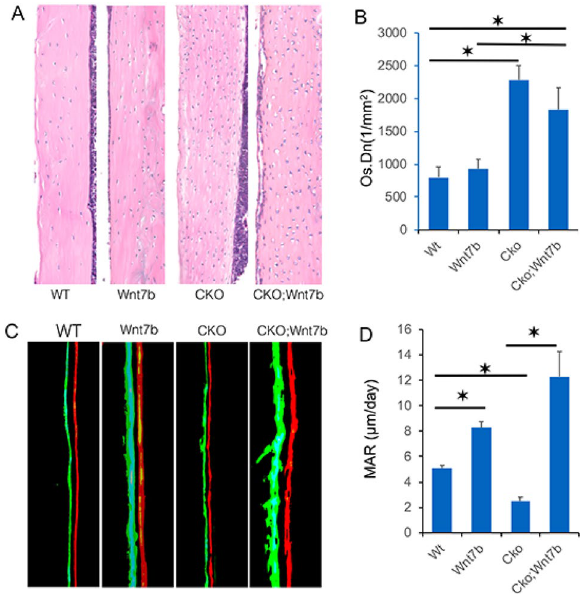
Figure 5. Overexpression of Wnt7b restores periosteal bone growth in Bmpr1a-deficient mice. ( A ) Representative H&E staining of the femoral cortical bone in littermate mice at P33. ( B ) Quantification of osteocyte density in the cortical bone. * P < 0.05, two-way ANOVA, n = 3 (females). ( C ) Representative images of calcein and alizarin double labeling at periosteal surface littermate mice at P33. ( D ) Quantification of mineral apposition rate (MAR). *: P < 0.05, two-way ANOVA, n = 3